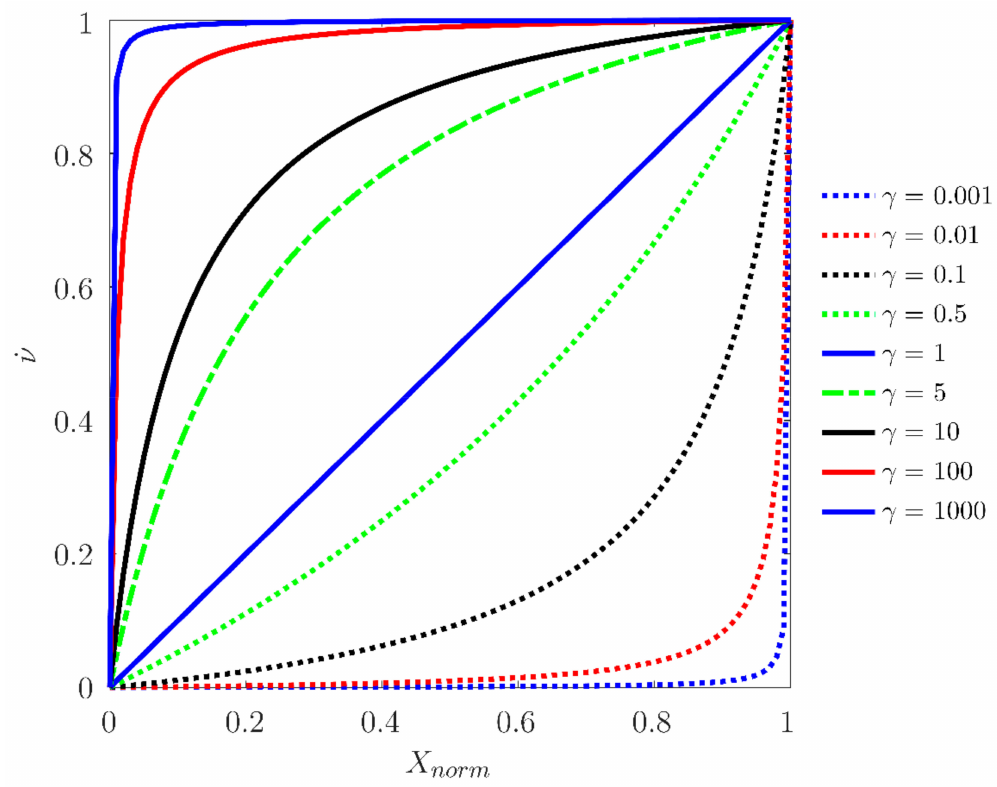
Figure 13. Variation of the normalized drying rate versus normalized moisture content for different values of γ